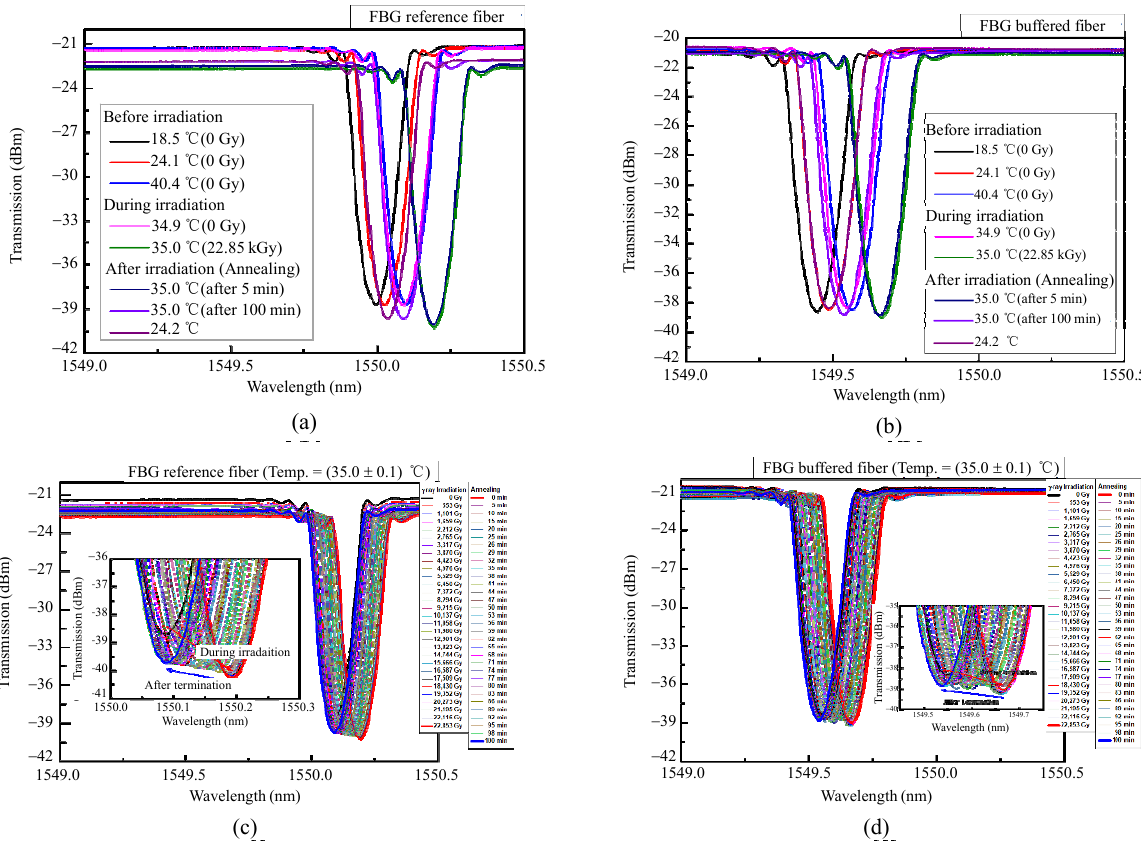
Fig. 6 Transmission spectra upon the change in temperature and the γ -ray irradiation conditions of (a) the FBG reference fiber, (b) the FBG buffered fiber and those during and after the γ -ray irradiation with the total dose of 22.85 kGy at 35 ℃ conditions, (c) the FBG reference fiber, and (d) the FBG buffered